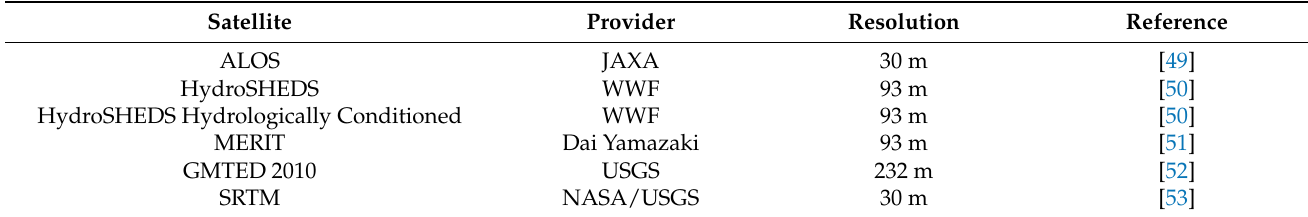
Table 2. Characters of the DEM data used in this study.